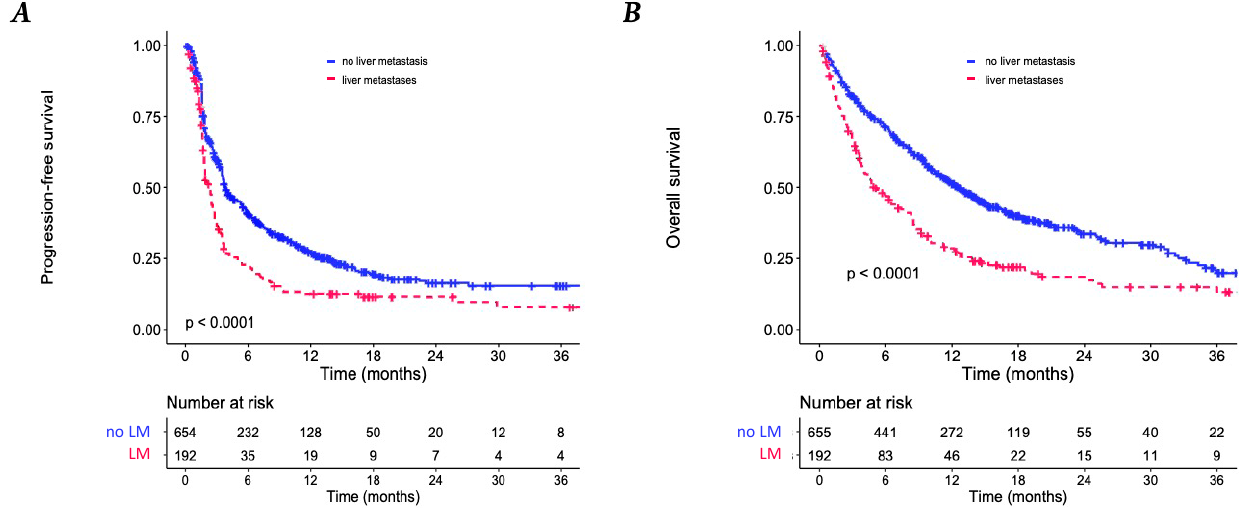
Figure 3. Kaplan–Meier analyses. ( A ) Progression-free survival (PFS) according to the presence of liver metastases (LM). ( B ) Overall survival according to the presence of LM. Analyses was adjusted with the presence of multiple MS, patient age, performance status, and tumor type, revealing that LM was an independent prognostic factor of PFS (adjusted HR = 1.57; 95% CI: 1.27–1.96; p < 0.001) and OS (adjusted HR = 1.77; 95% CI: